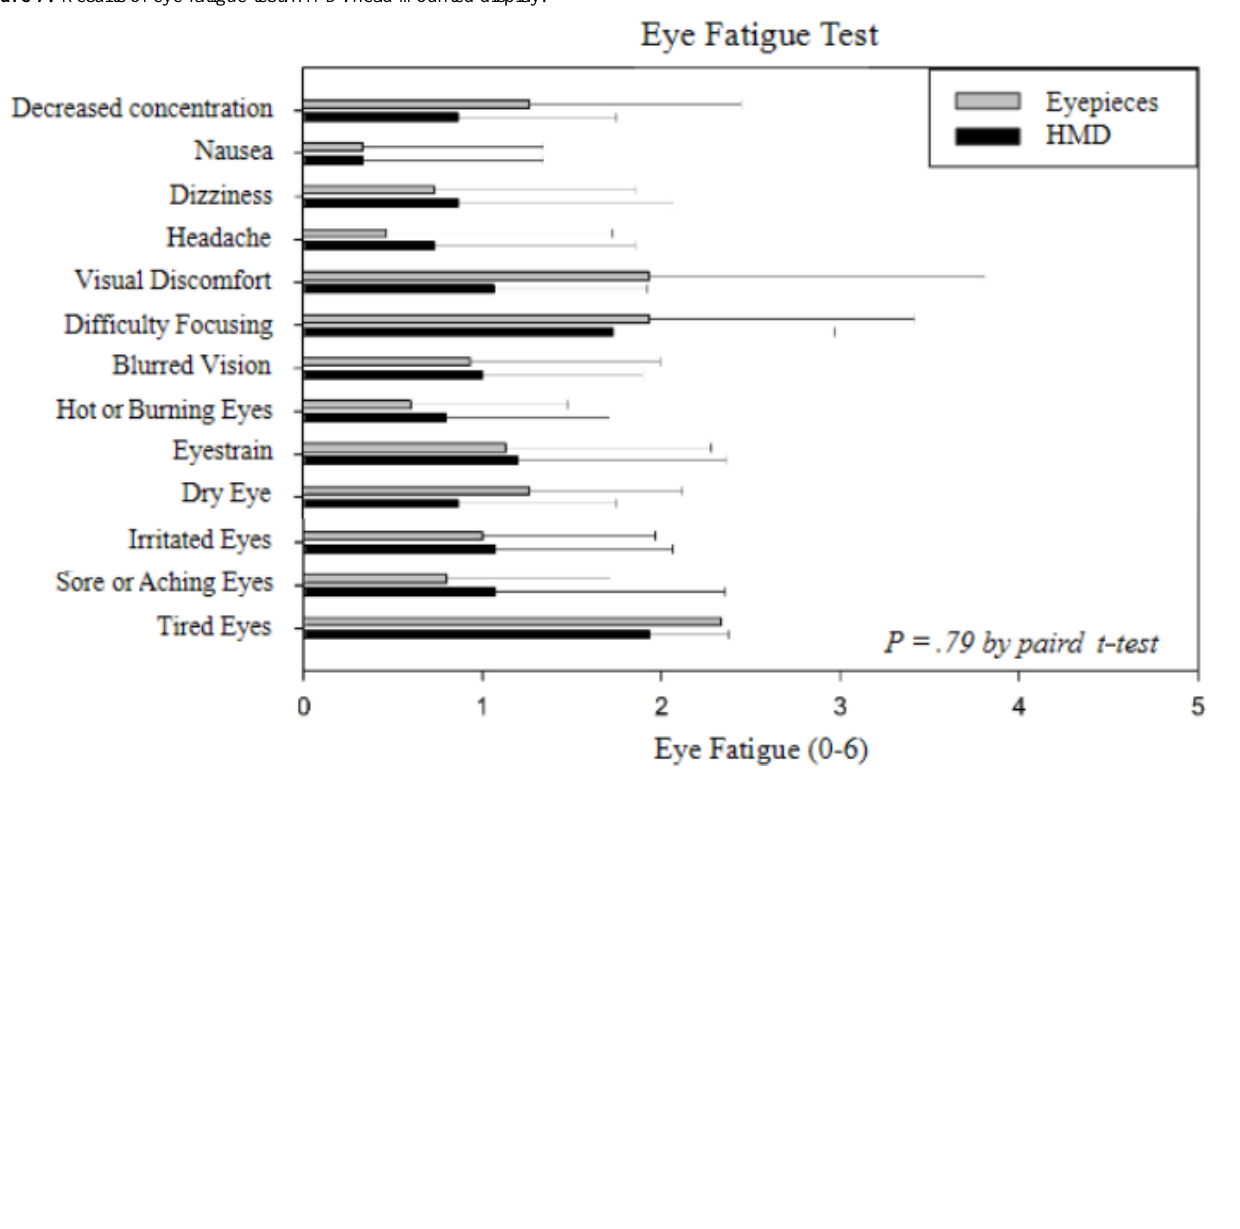
Figure 7. Results of eye fatigue test. HMD: head-mounted